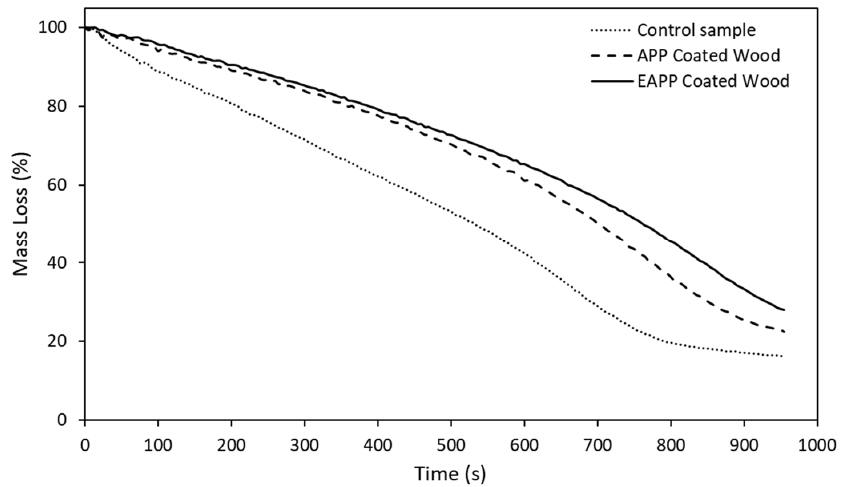
Figure 8. MLR curves of intumescent coated wood samples and control wood sample.